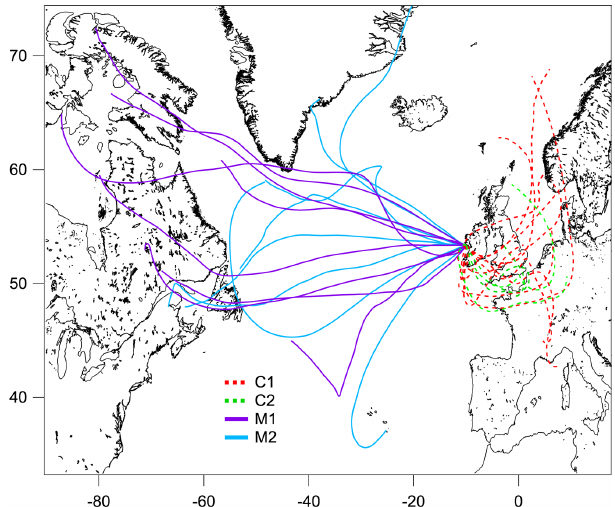
Figure 2. The 72h backward trajectories arriving at 500m above mean sea level at Mace Head, retrieved with the Global Data As- similation System, for the continental (C1 – red dashed line; C2 – green dashed line) and marine (M1 – purple solid line; M2 – blue solid line) events. The trajectory was calculated every 24h over the event